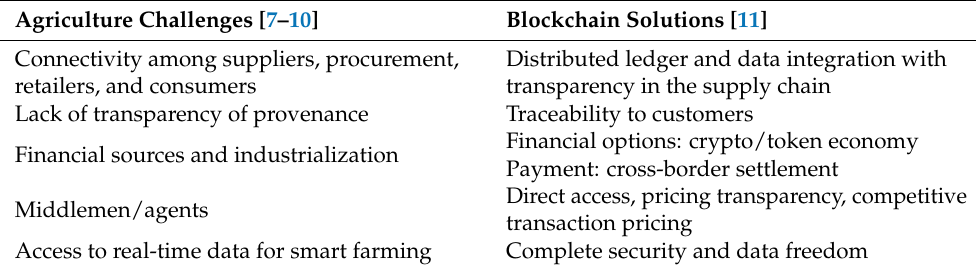
Table 1. Agriculture challenges mapped to blockchain-based solutions.